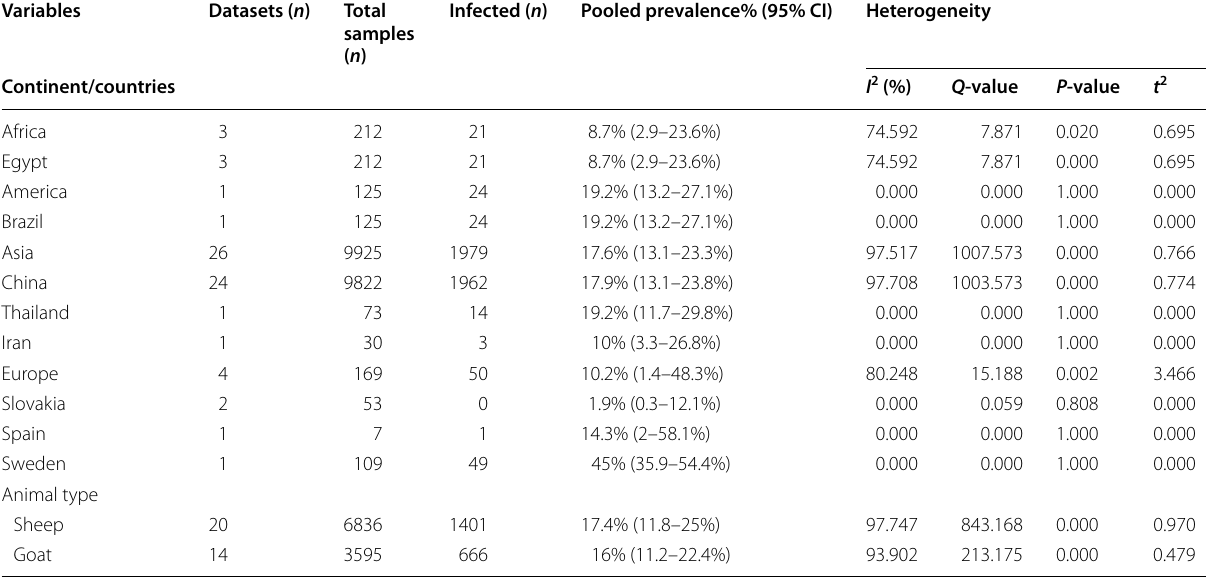
Table 2 Subgroup analysis of continents, countries and animal type (sheep and goats), based on molecular methods Variables